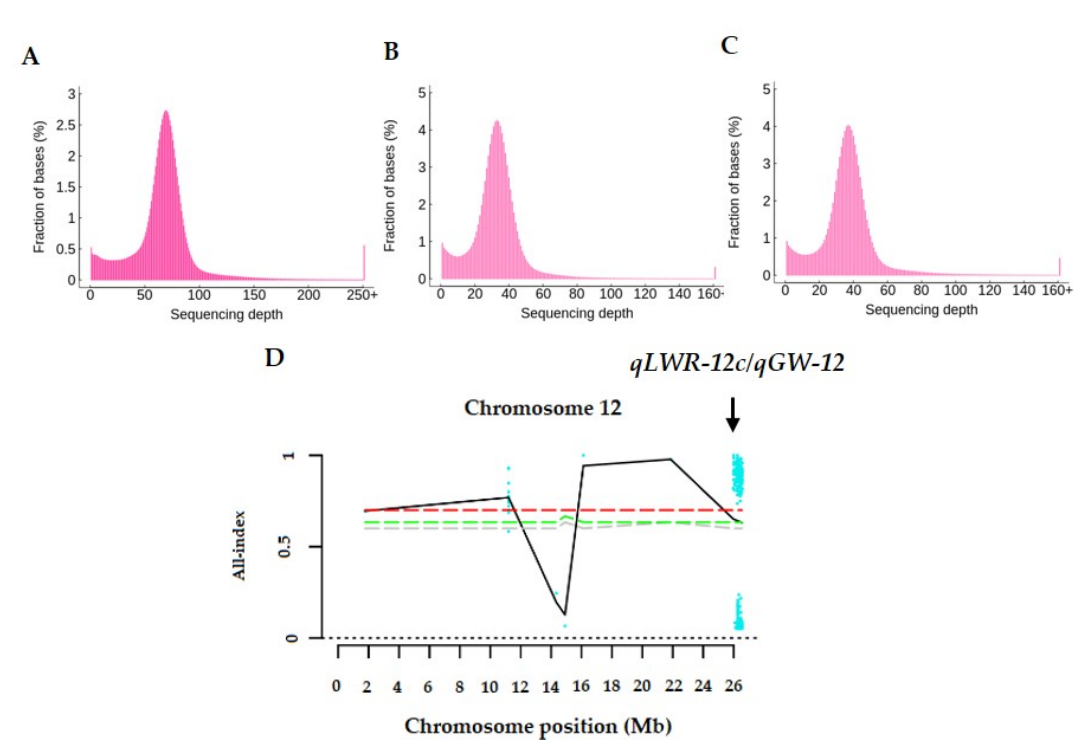
Figure 4. Candidate region of qLWR-12c/qGW-12 . ( A ) Mixed pool sequencing depth. ( B ) Q42 sequencing depth. ( C ) Q43 sequencing depth. ( D ) Distribution of progeny all-index on chromosome 12. Table 4. Candidate genes for qLWR-12c/qGW-12 obtained in bulk segregant analysis.